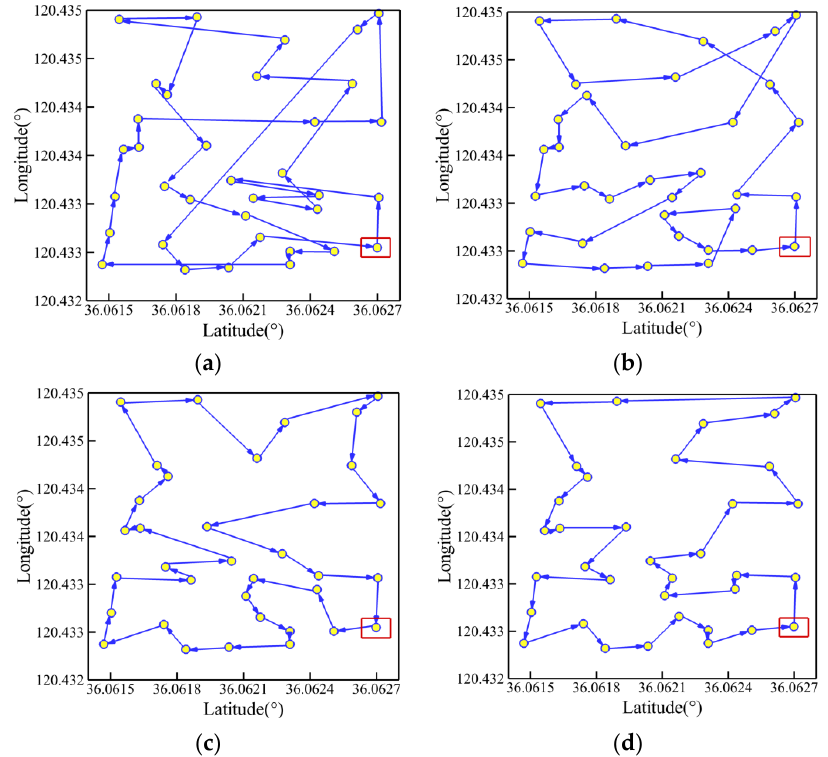
Figure 8. Trajectory planned by each algorithm for Q = 35: ( a ) CPSO; ( b ) APSO; ( c ) AWPSO; ( d ) AWIPSO.